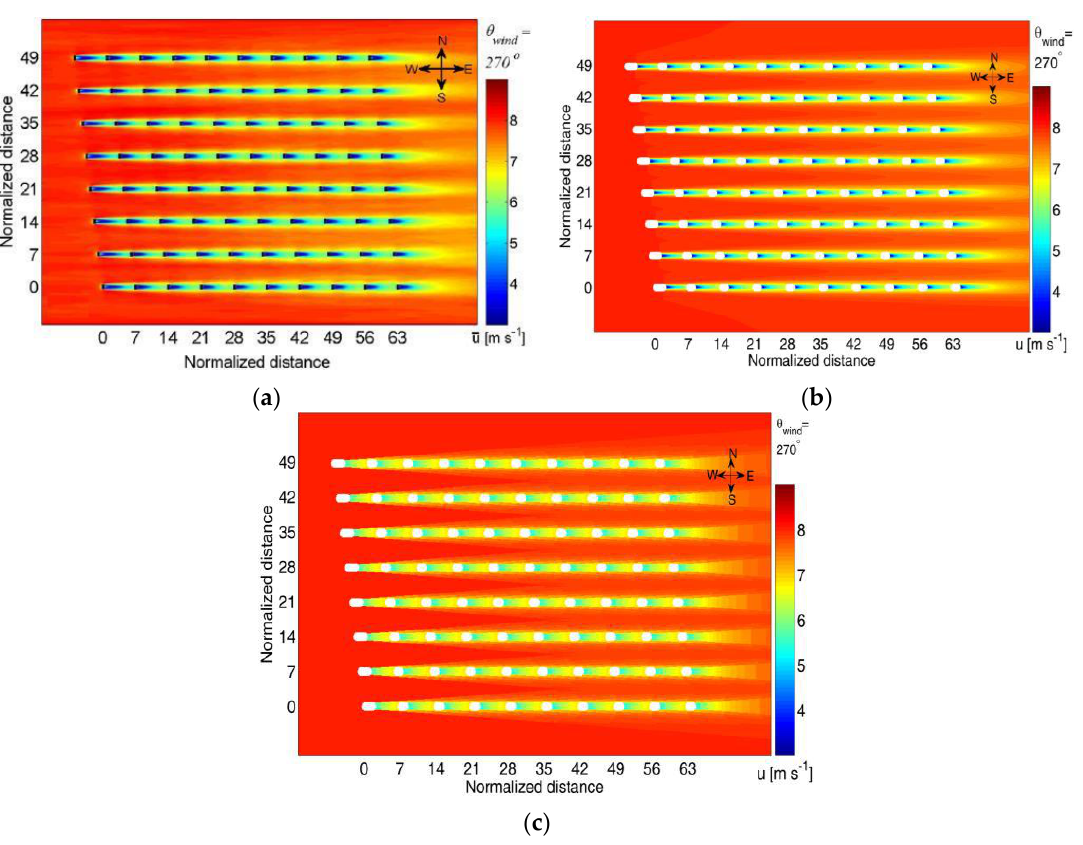
Figure 9. Comparison of the time-averaged streamwise velocity at a horizontal plane at hub height: ( a ) LES; ( b ) new analytical model and ( c ) top-hat model.